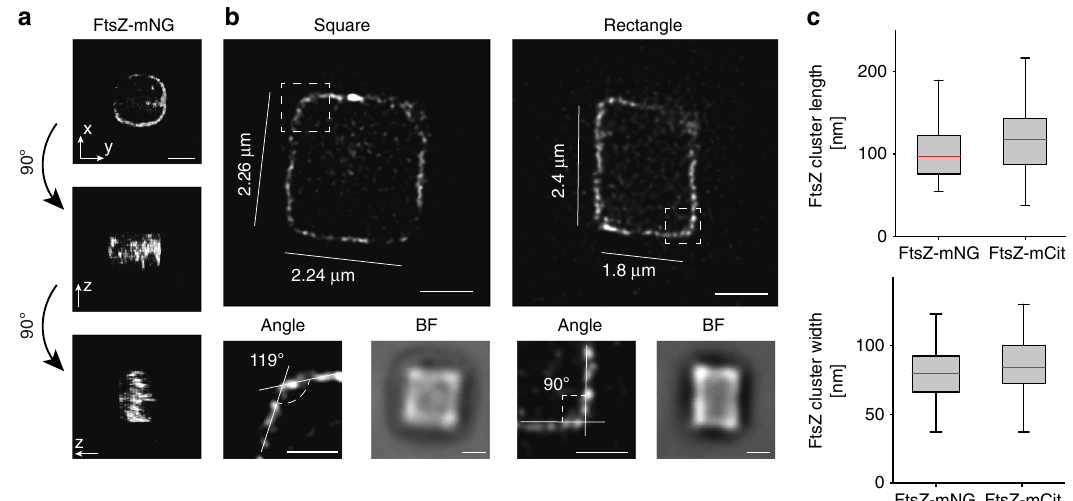
Fig. 3 FtsZ-squares and FtsZ-rectangles in shaped cells. Drug-treated (A22 and cephalexin) E. coli cells expressing FtsZ-mNeonGreen were sculpted into rectangular shapes and imaged using super-resolution STED nanoscopy. a 3D rendering of a confocal Z-stack of an FtsZ-mNeonGreen square, showing only one band of FtsZ. Note that information along the z -axis is elongated. b Representative STED images of FtsZ-mNeonGreen in square (left) and rectangular (right) cells with perimeters ranging from 8.4 to 11.52 μ m (compared to WT ~ 3 μ m). Additional examples are provided in Supplementary Figure 13. Close-up images show representative corner angles. BF, bright fi eld image of corresponding cells. c Quanti fi cation of FtsZ cluster dimensions, showing little difference between FtsZ-mNeonGreen (105.4 ± 39.6 nm, 79.6 ± 18.2 nm; mean ± S.D., length and width, respectively. n = 147) and FtsZ- Figure 14). Scale bars = 1 μ m. Boxes represent S.D., with red lines indicating mean. Whiskers on the box plots encompass 95.5% of the